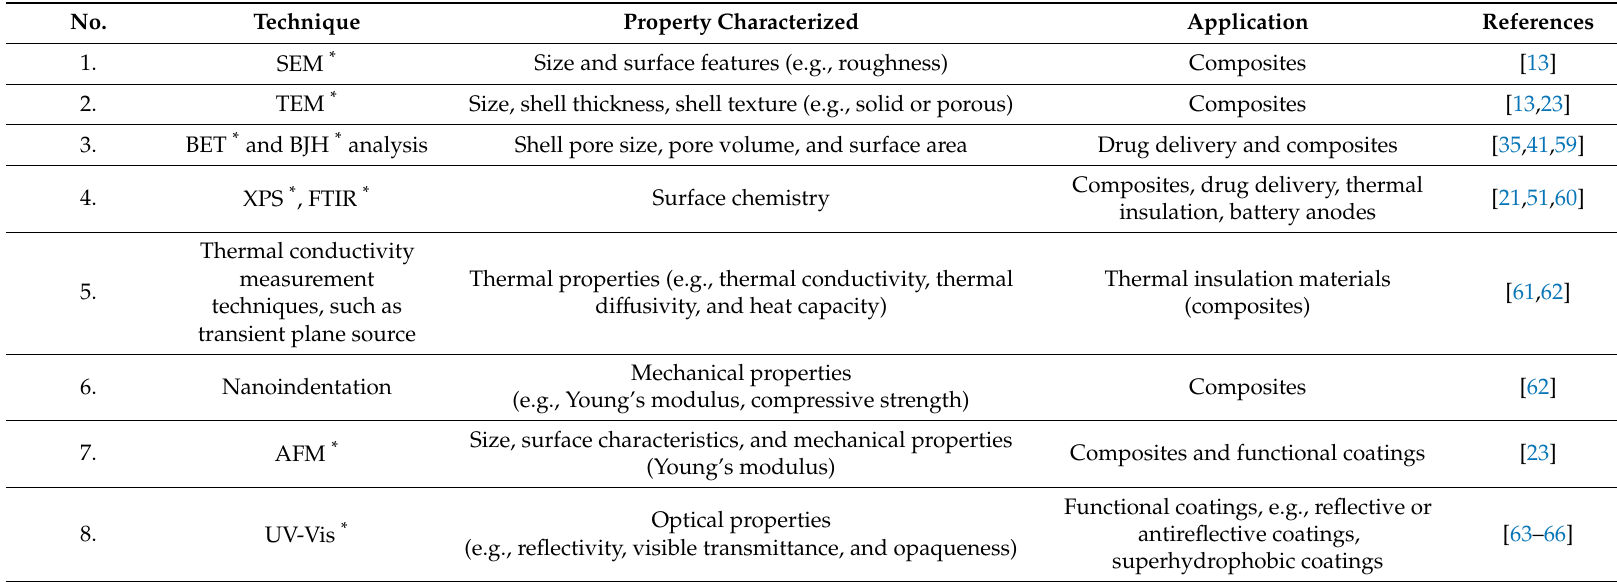
Table 2. Techniques and specific properties